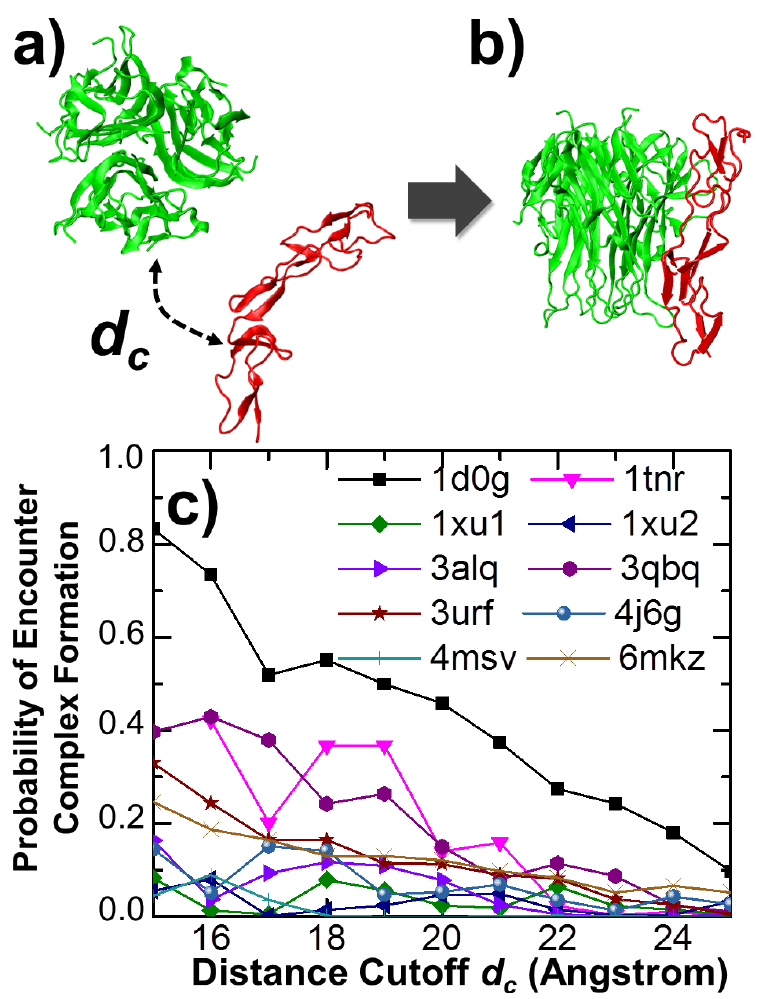
Figure 3. We applied a residue-based kinetic Monte Carlo method to simulate the association between ligands and receptors of all the 10 protein complexes. The monomeric receptor was first separated from its trimeric ligand within different values of distance cutoff (a) . Under each distance cutoff, 10 3 simulation trajectories were generated from different initial conformations. Ligands and receptors can successfully associate together within some of these trajectories (b) . We then counted the probability of finding the encounter complexes among these trajectories. The association probabilities for different protein complexes are plotted in (c) as a function of distance cutoff.